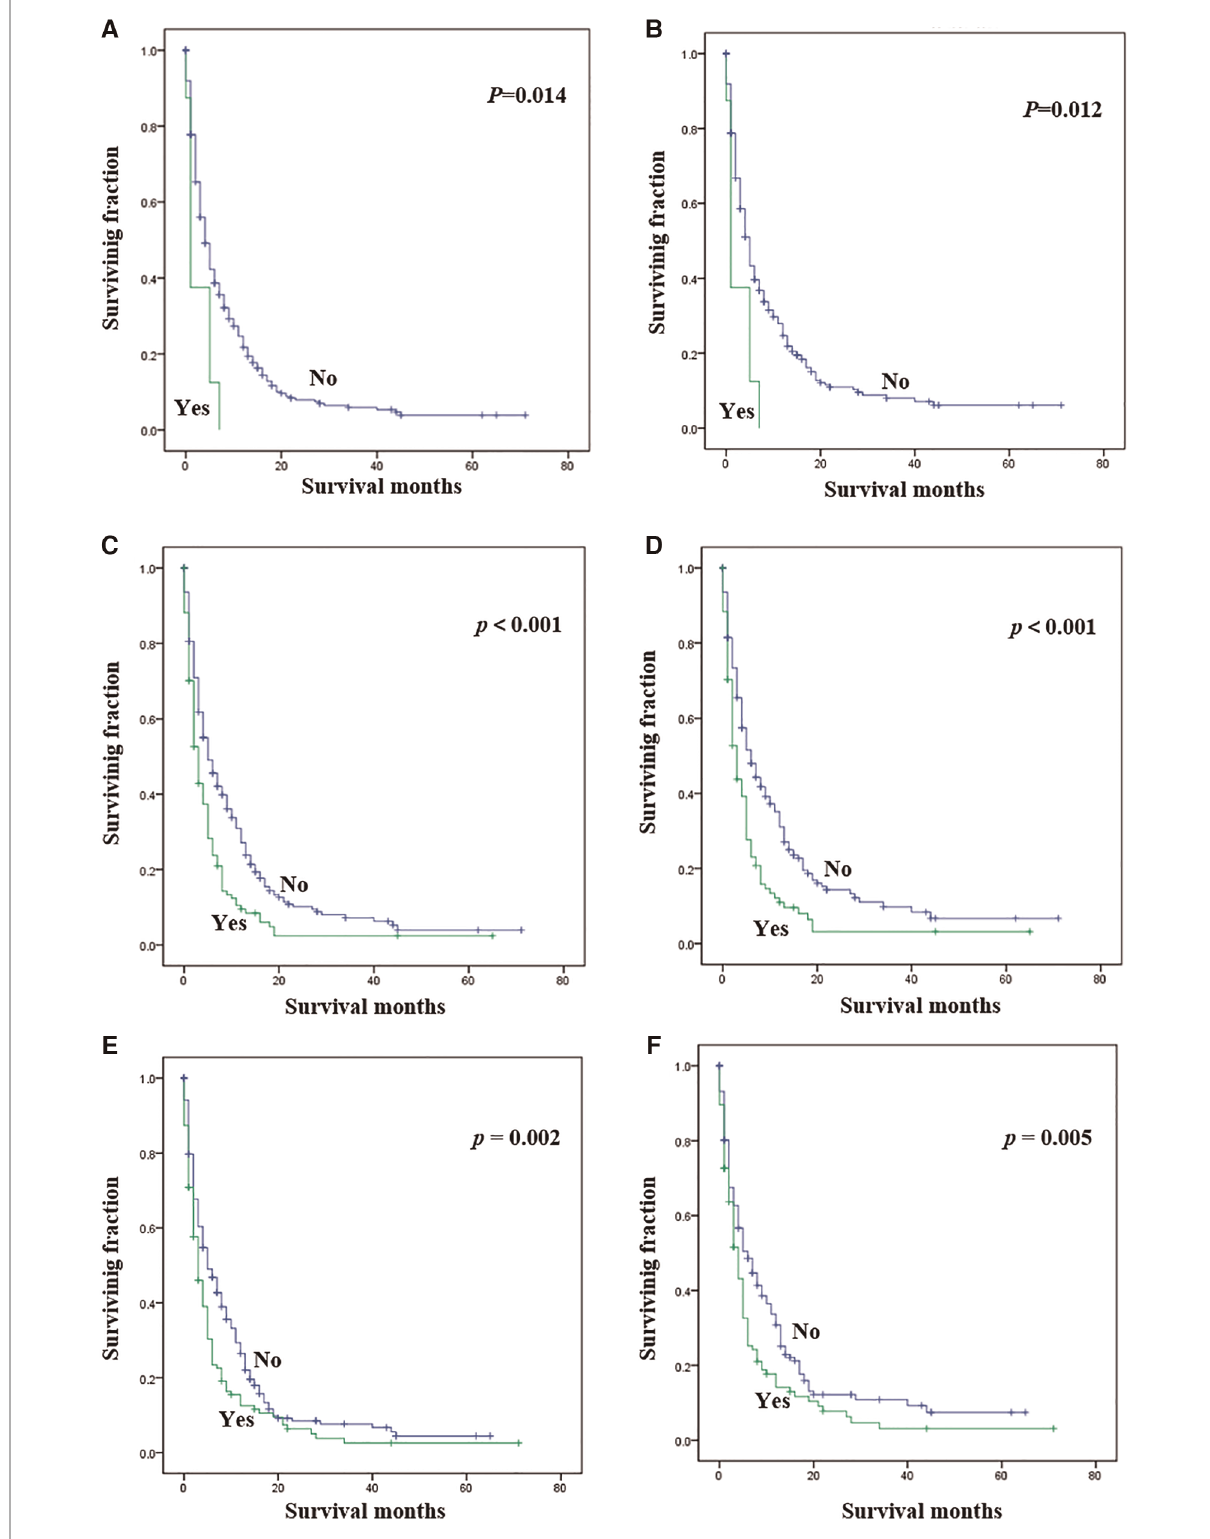
FIGURE 3 Kaplan-Meier method estimated OS and CSS in UTUC patients with bone metastasis strati fi ed by visceral metastasis. ( A ) OS strati fi ed by brain metastasis; ( B ) CSS strati fi ed by brain metastasis; ( C ) OS strati fi ed by liver metastasis; ( D ) CSS strati fi ed by liver metastasis; ( E ) OS strati fi ed by lung metastasis; ( F ) CSS strati fi ed by lung metastasis. (UTUC, upper-tract urothelial carcinoma; OS, overall survival; CSS, cancer-speci fi c